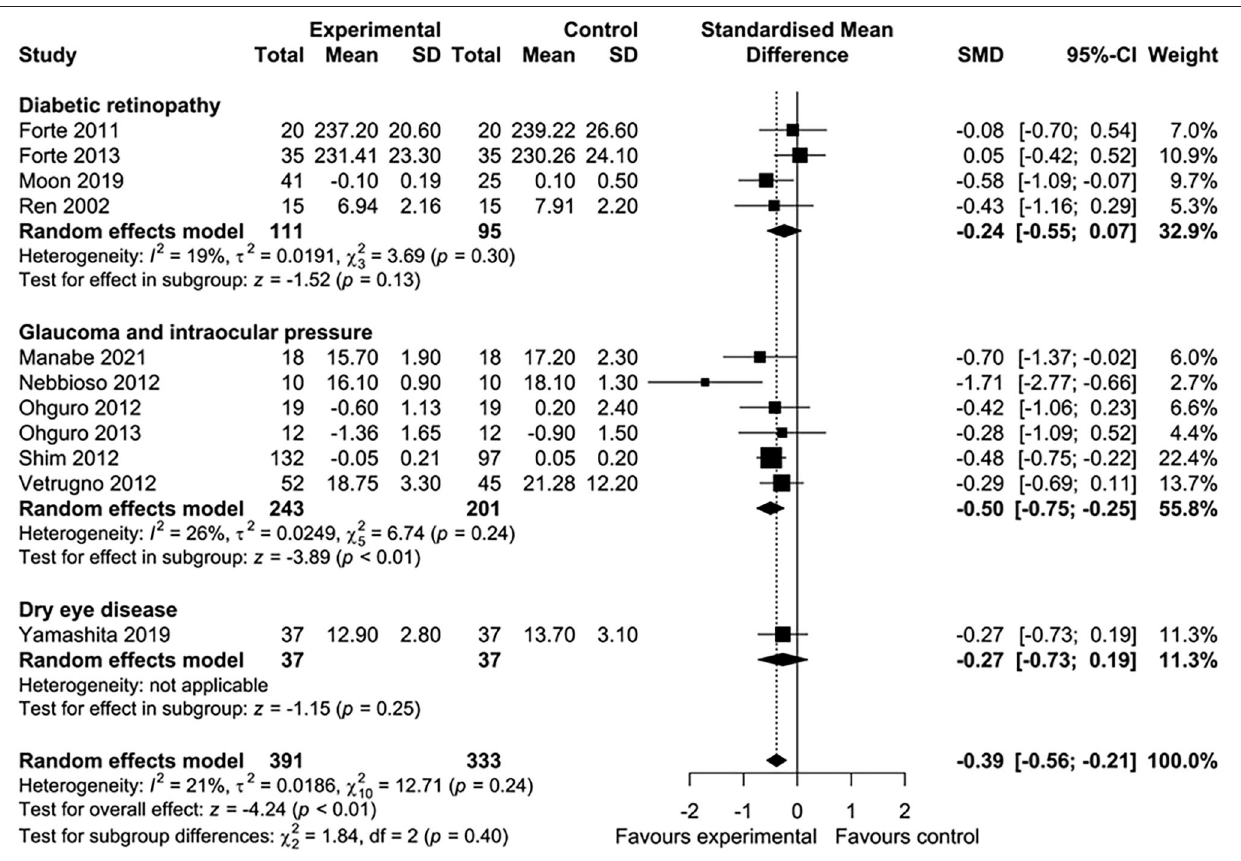
FIGURE 3 | Meta-analysis to assess the effect of flavonoids in different subgroups of ocular